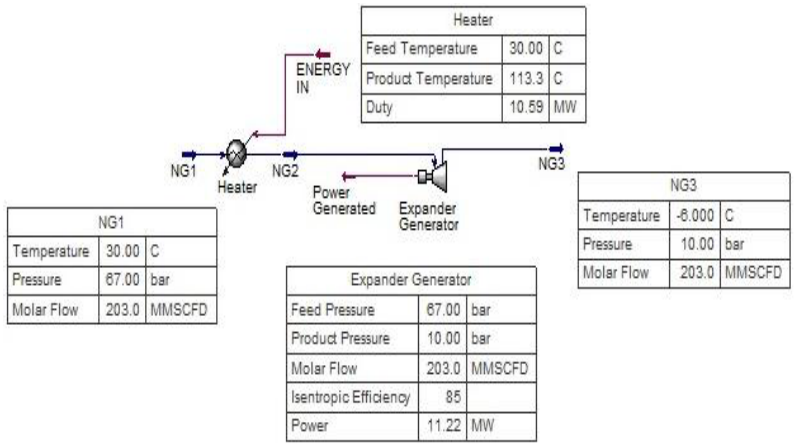
Figure 5. Modeling of the first scenario using the commercially available software.